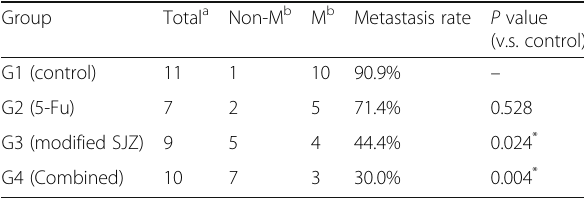
Table 1 Modified SJZ ’ s inhibitory effect on colon cancer liver metastasis